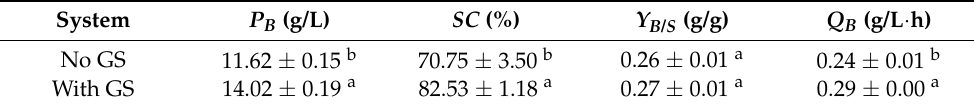
Table 12. Batch butanol fermentation efficiency levels from SSJ medium with immobilized C. beijerinckii TISTR 1461 in 2 L STRs with and without a gas stripping system (GS) at 48 h